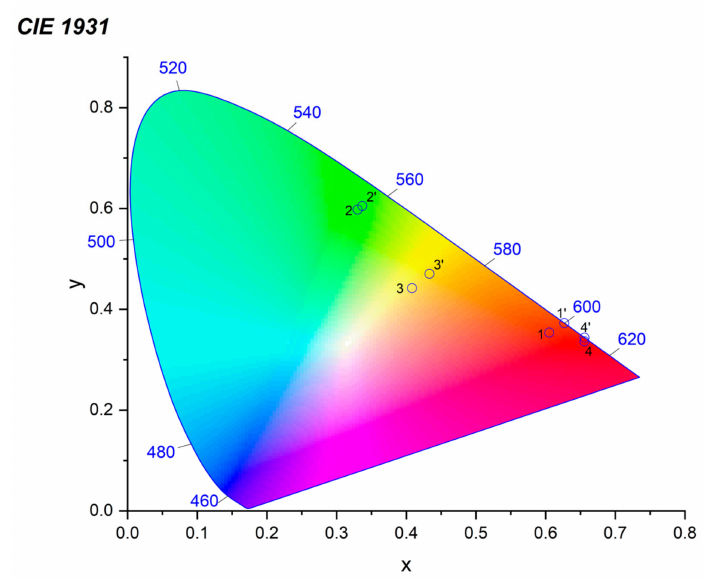
Figure 12. CIE diagram for complexes 1, 6, 2, 7, 3, 8, 4 and 9